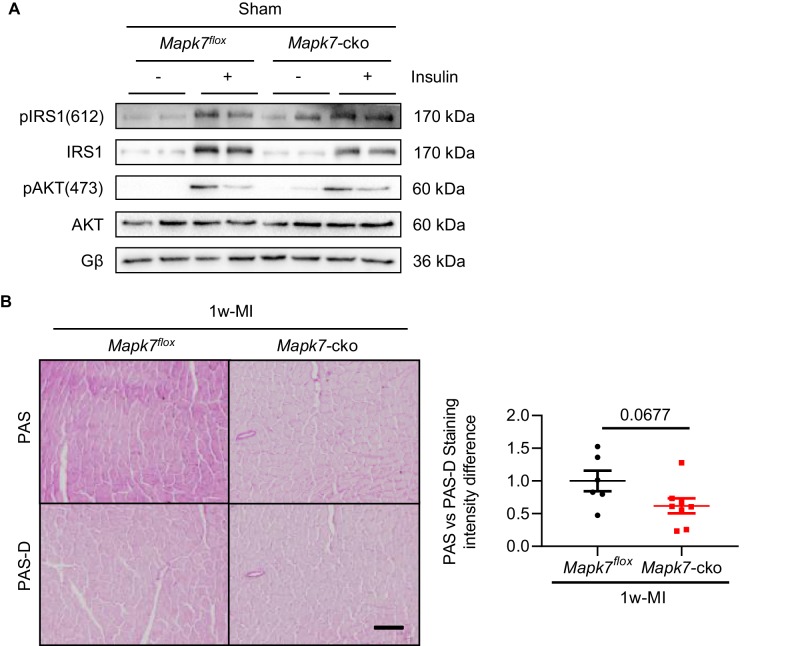
Activation of the insulin cascade in sham mice and cardiac glycogen detection one week post-MI.(A) Immunoblots illustrated that insulin-stimulated (insulin IP injection, 1 U/kg for 30 mins) activation of IRS1 and AKT was at a comparable level in the myocardium from Mapk7flox and Mapk7-cko under basal condition (N = 5–6 mice). (B) Glycogen in the hearts from 1w-MI stressed Mapk7flox and Mapk7-cko mice was detected by Periodic Acid Schiff (PAS) staining. Diastase treatment was to discern unspecific staining (PAS-D) (N = 6–8 mice). Scale bar: 50 µm. Quantification of positive glycogen content is provided. Data presented as mean ± SEM. Groups were compared using two-tailed Student’s t-test.Figure 4—figure supplement 3—source data 1.Activation of the insulin cascade in sham mice and cardiac glycogen detection one week post-MI.